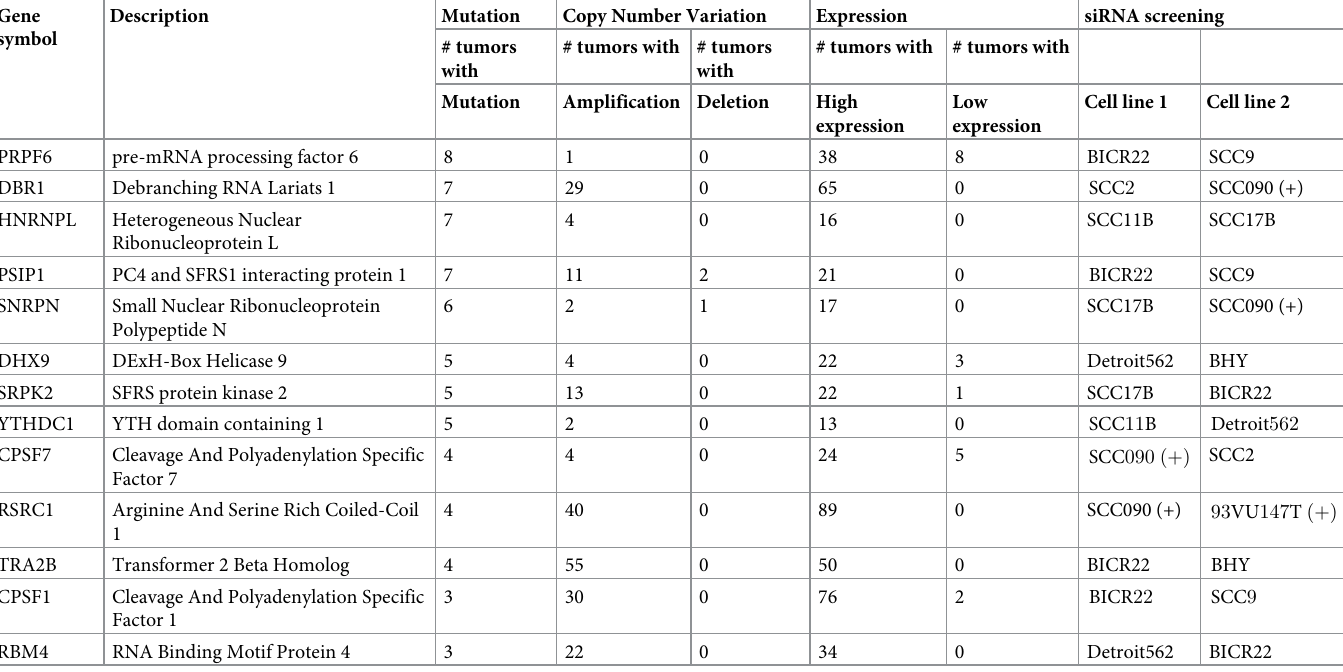
Table 1. Thirteen candidate genes with high number of mutation, copy number variation and expression in TCGA. Gene Description Mutation Copy Number Variation Expression siRNA screening symbol